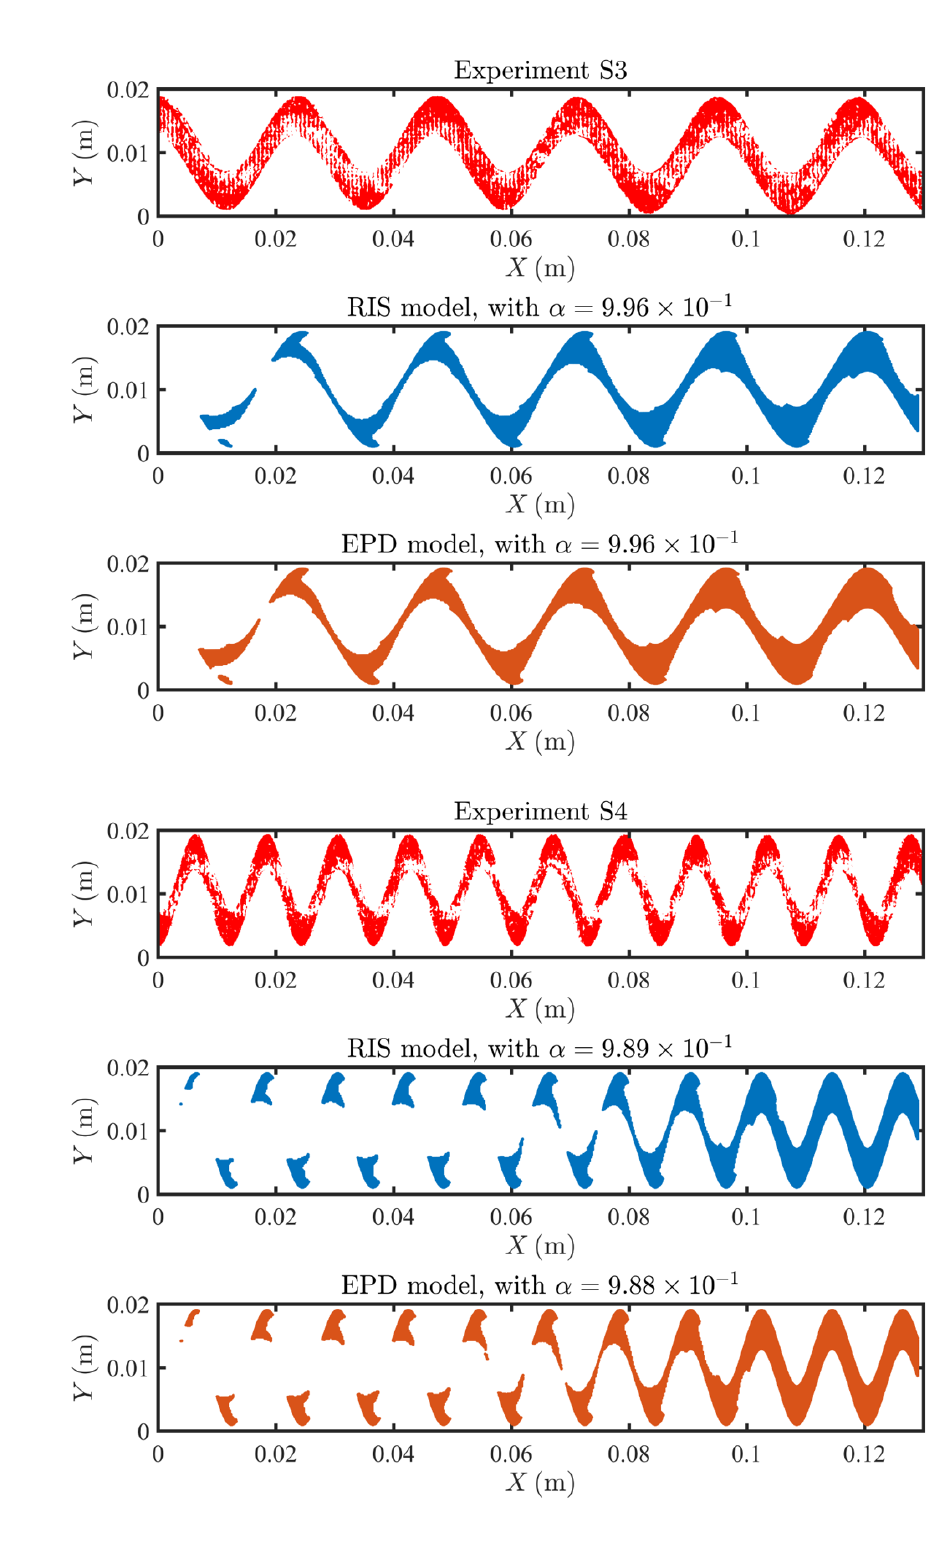
Figure 9. Comparison of the fouling pattern of S3 and S4, between the experimental results (in red), the RIS model simulation results (in blue) and the EPD model (in